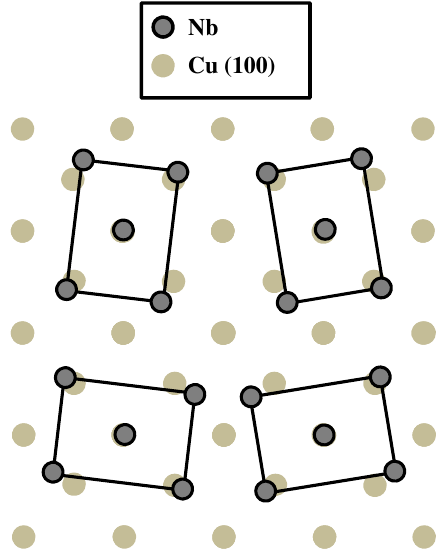
FIG. 4. Overlays of relaxed Nb lattices on a Cu(100)